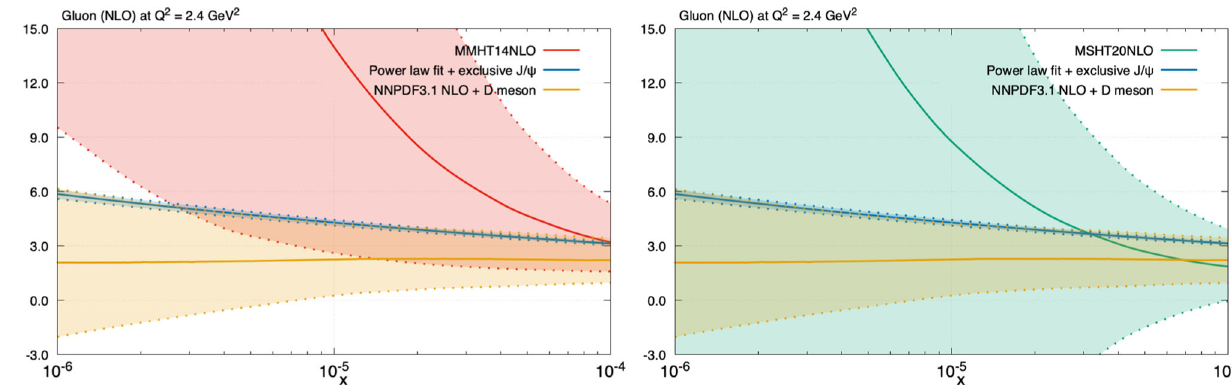
Fig. 88 Comparison of the MMHT14 (left) and MSHT20 (right) NLO gluon PDFs at Q 2 = 2 . 4 GeV 2 with a power-law fit to exclusive J /ψ data [35] and a NNPDF3.0 fit with the addition of LHCb D meson data